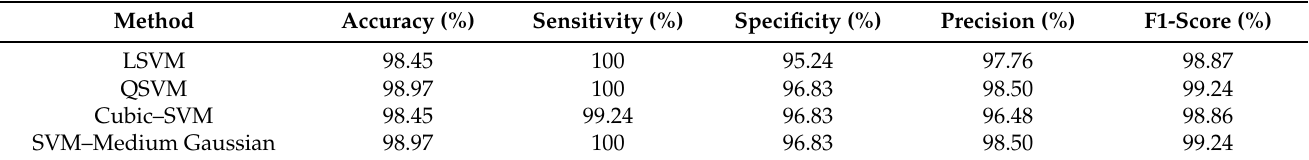
Table 5. DenseNet201 activated feature based classification using 70%-30% split.